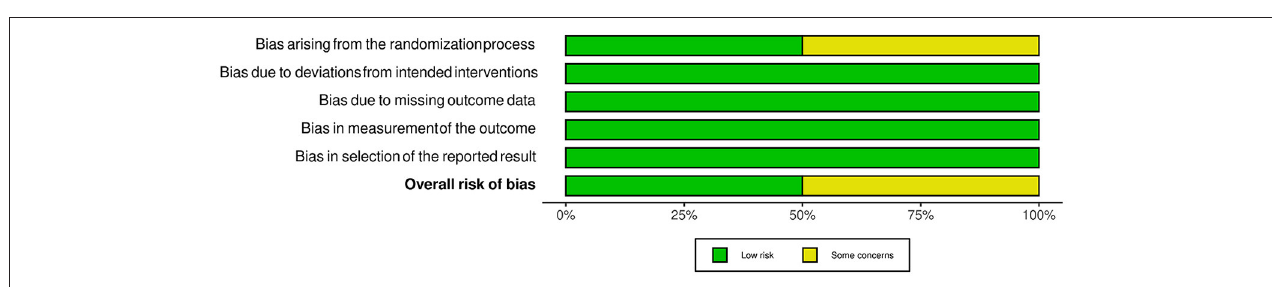
FIGURE 3 | Overall risk of bias for randomized control trials.